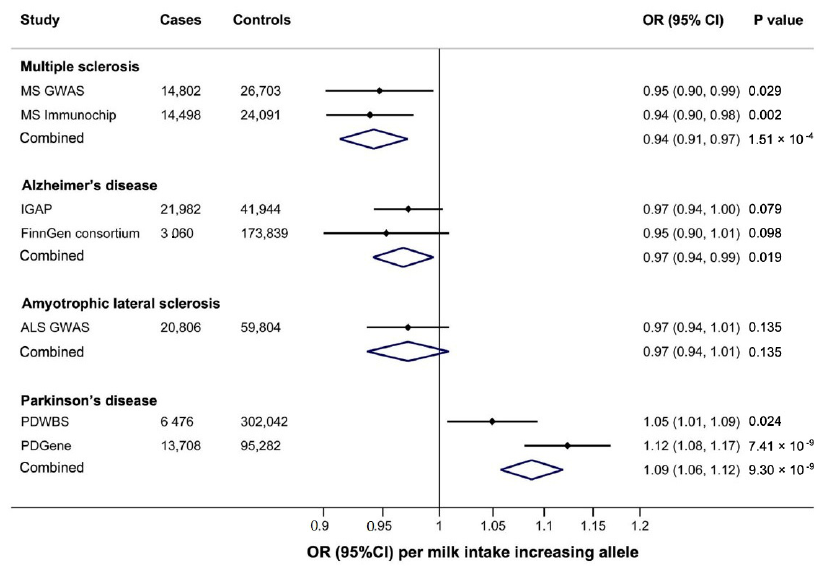
Figure 3. Association of genetically predicted higher milk intake with neurodegenerative diseases. CI: confidence interval, OR: odds ratio, IGAP: International Genomics of Alzheimer’s Project, PDWBS: Web-Based Study of Parkinson’s